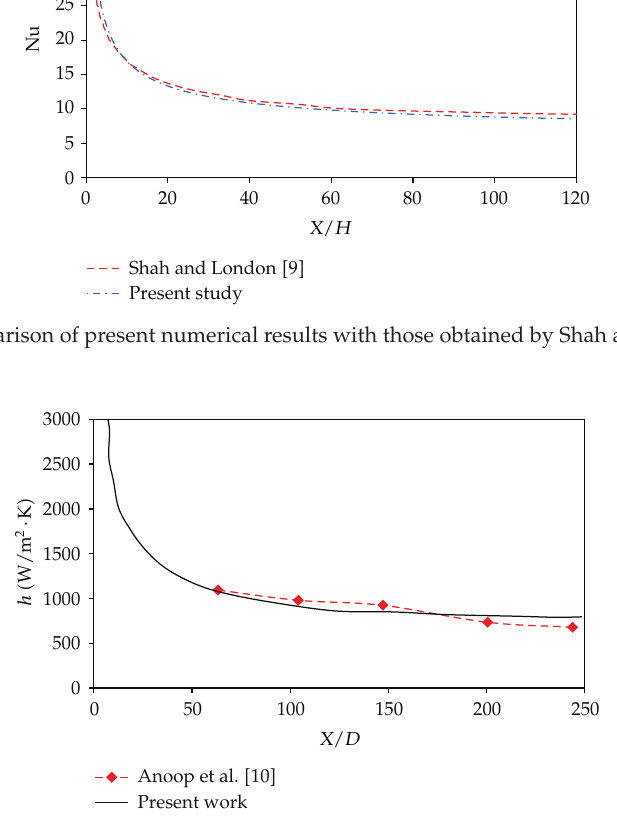
Figure 4: Comparison of heat transfer coe ffi cient between present simulation and experimental data (cid:8) 10 (cid:9) for water-Al 2 O 3 nanofluid with φ (cid:4) 4% in the circular